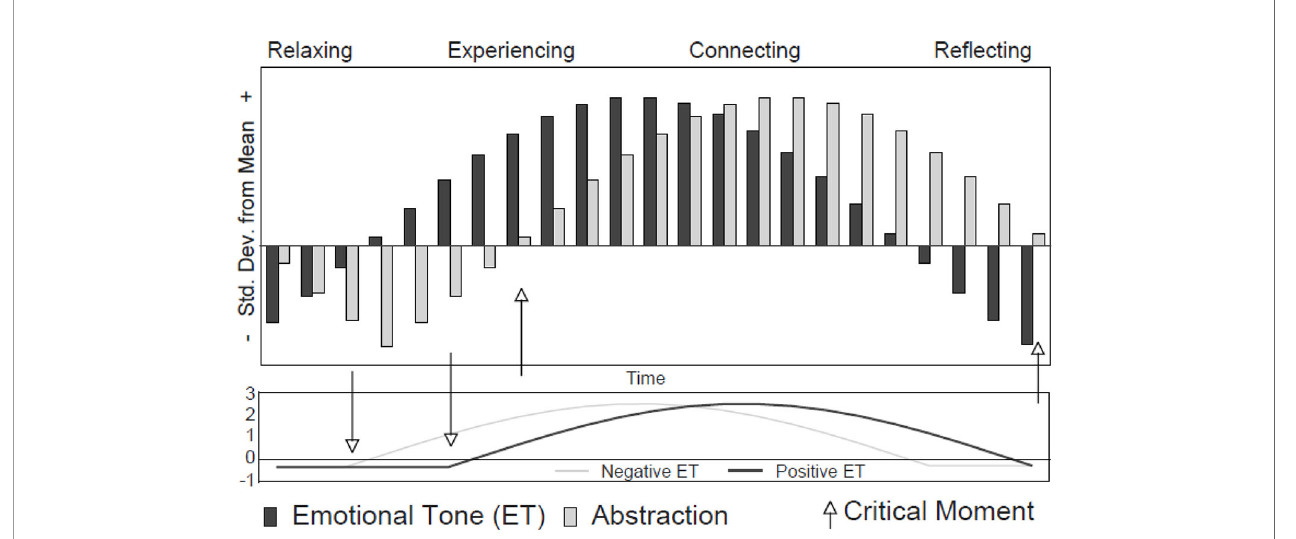
FIGURE 1 | Prototypical depiction of the Therapeutic Cycles Model. (22, p.